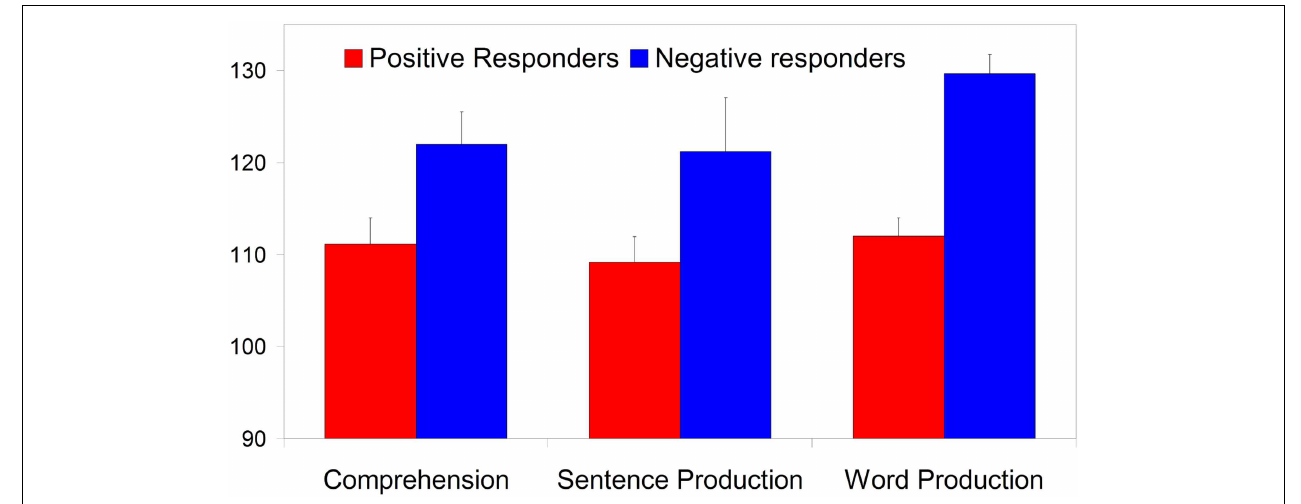
FIGURE 6 |The three language quotients at 3years split by group performances at 7months (error bars are one standard error from the mean). The group differences on comprehension and word production are significant (at p < 0.05 and p < 0.001 respectively), the sentence production difference just misses significance ( p = 0.052).